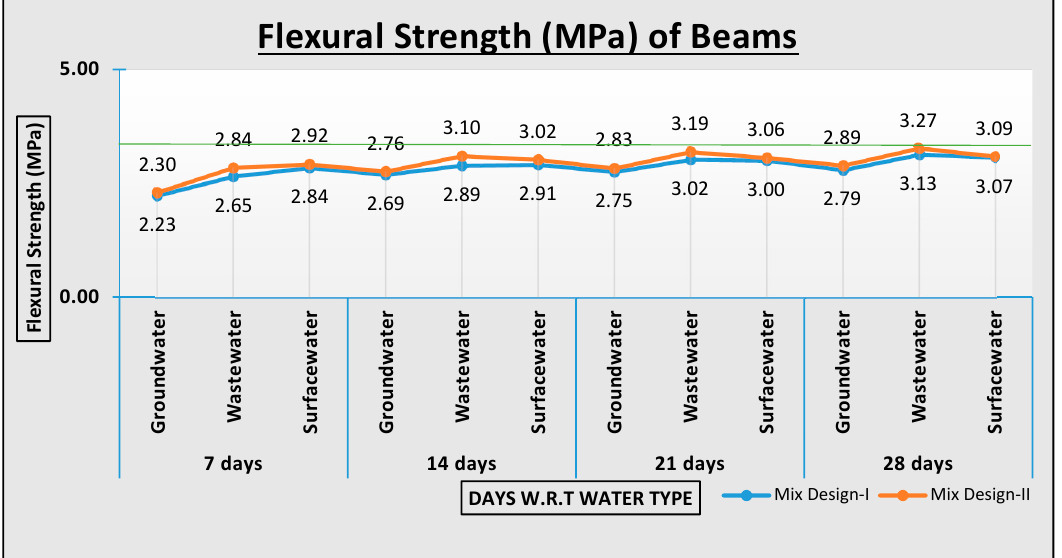
Figure 12. Comparative analysis for the impact of water quality on flexural strength with respect to mix design.